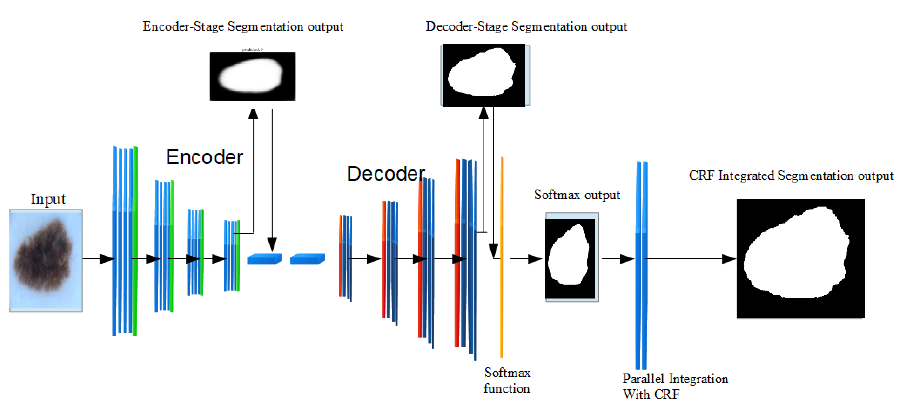
Figure 3. The proposed architectural diagram for a fully convolutional deep learning system en- hanced with a probabilistic